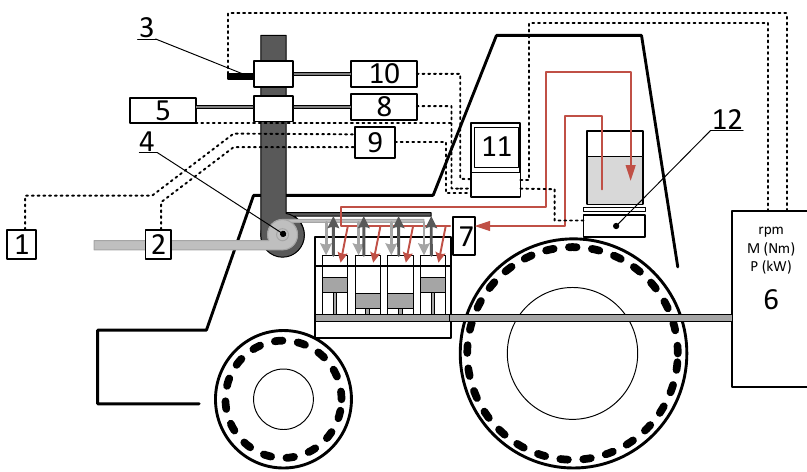
Figure 1. Measurement scheme: ( 1 )—sensor of pressure and temperature of intake air, ( 2 )—mass air flow sensor, ( 3 )—exhaust gas temperature sensor, ( 4) —turbocharger, ( 5 )—opacimeter BrainBee OPA 100, ( 6 )—dynamometer MAHA ZW 500, ( 7 )—fuel pump, ( 8 )—emission analyzer BrainBee AGS 200, ( 9 )—A/D converter LabJack U6, ( 10 )—EEPS, ( 11 )—PC for control and data record, ( 12 )—laboratory scale with external fuel tank.